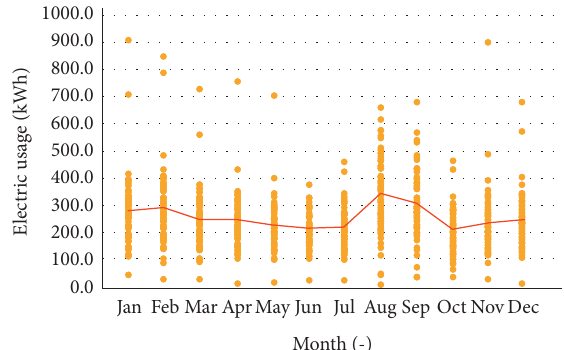
Figure 7: Monthly electric usage (data collected through utility bills).